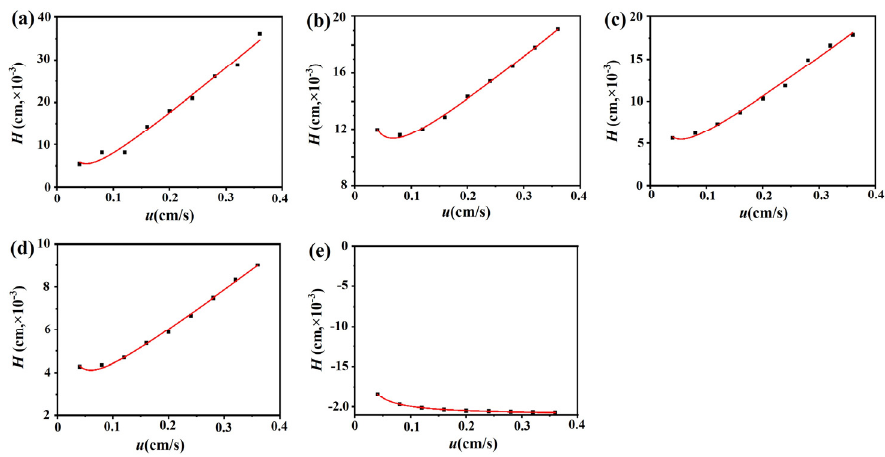
Figure 6. Fitting plots of the three M3R-bound drugs, sodium nitrate, and the theoretical non- retained substance. Fitting curves of the M3R-bound linear velocity (u) vs. plate height (H) of sodium nitrate ( a ), atropine sulfate ( b ), pilocarpine ( c ), ( − )-scopolamine hydrochloride ( d ), and the theoretical non-retained substance ( e ).